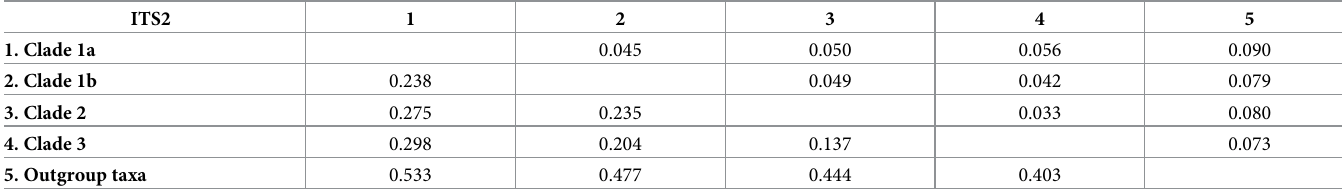
The simultaneous ITS2 S2 alignment was used to calculate the genetic distances among groups via the log-det (Tamura-Kumar) method using MEGA-X V10.1.8 software. The values represent the number of base substitutions per site obtained by averaging over all sequence pairs between groups. The standard error estimates are shown in blue.